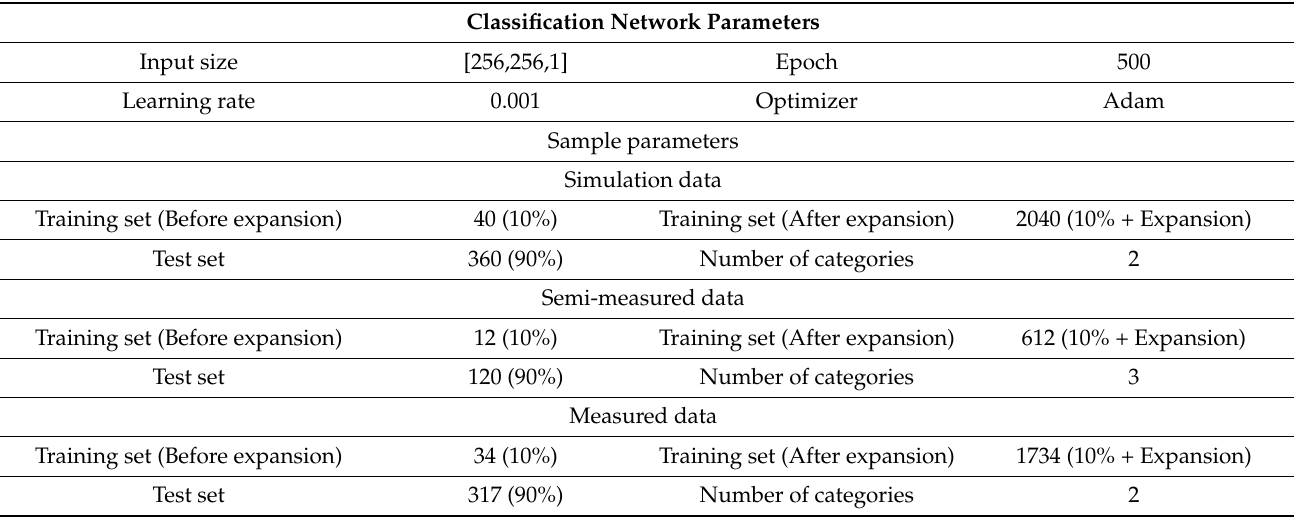
Table 7. Parameters of the classification network and samples. Classification Network